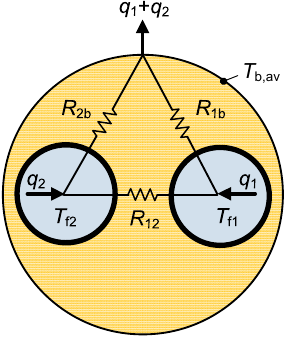
Figure 1. Δ resistance network for a single U-tube in a borehole. Figure 1. ∆ resistance network for a single U-tube in a